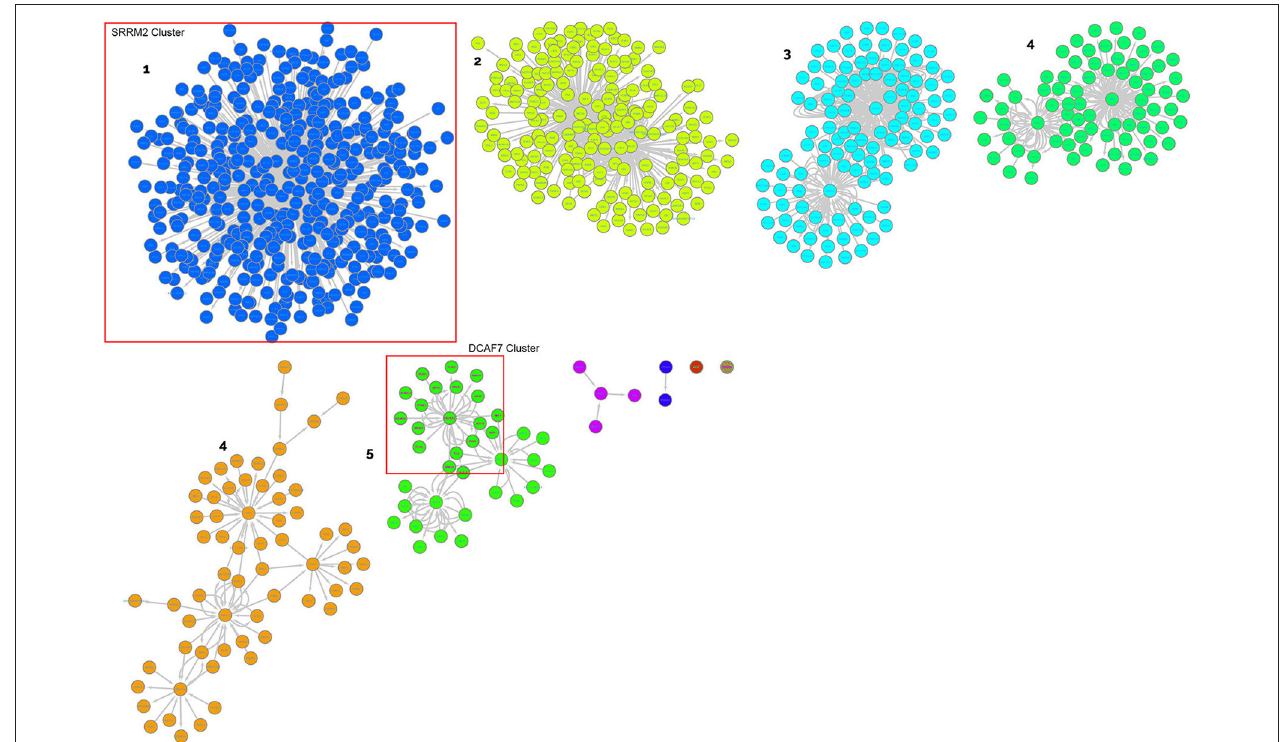
FIGURE 4 | Clusters of proteins from the target analysis of down-regulated miRNAs. Each cluster is named with the central node protein name, targeted from the highest number of miRNAs.